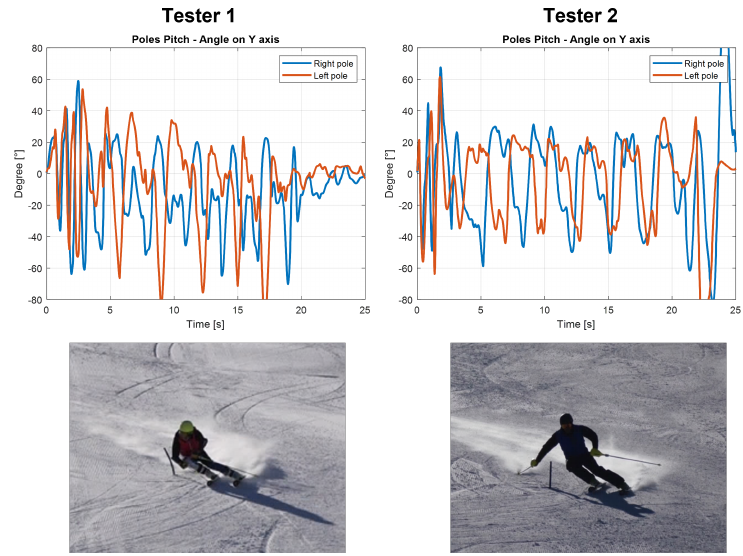
Figure 12. Pitch angle for right and left pole for Testers 1 and